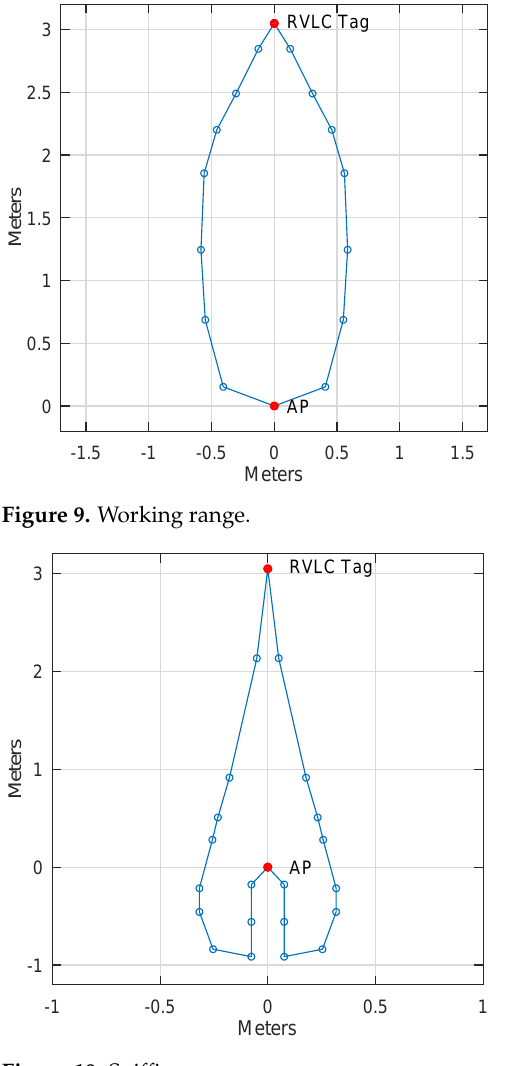
Figure 10. Sniffing